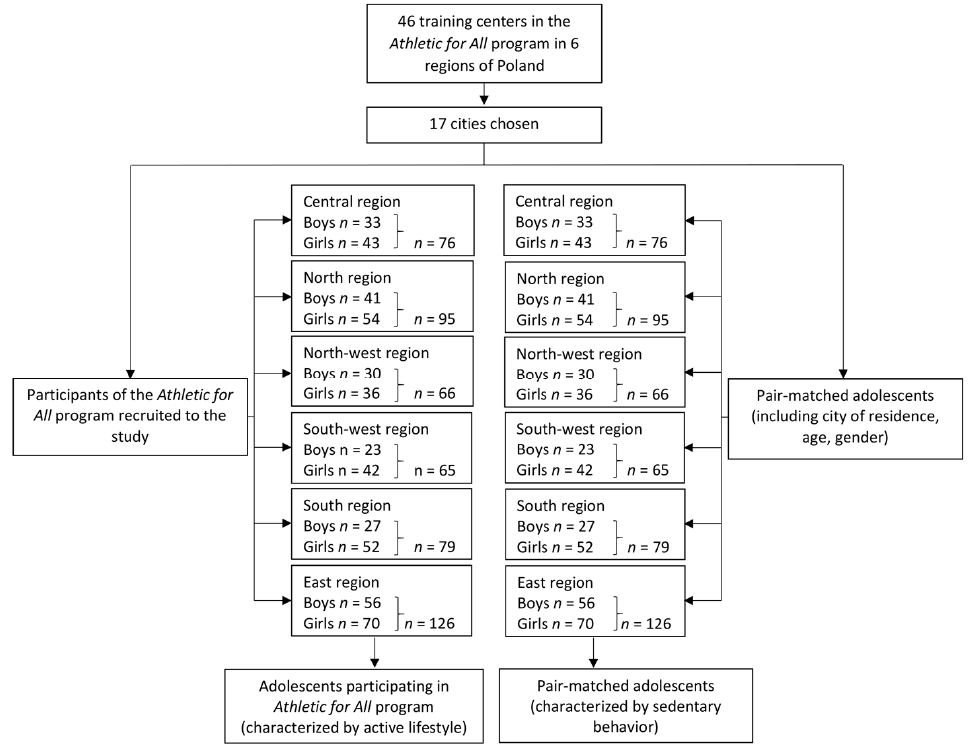
Figure 2. The geographical breakdown of the participants of the #goathletics Study.